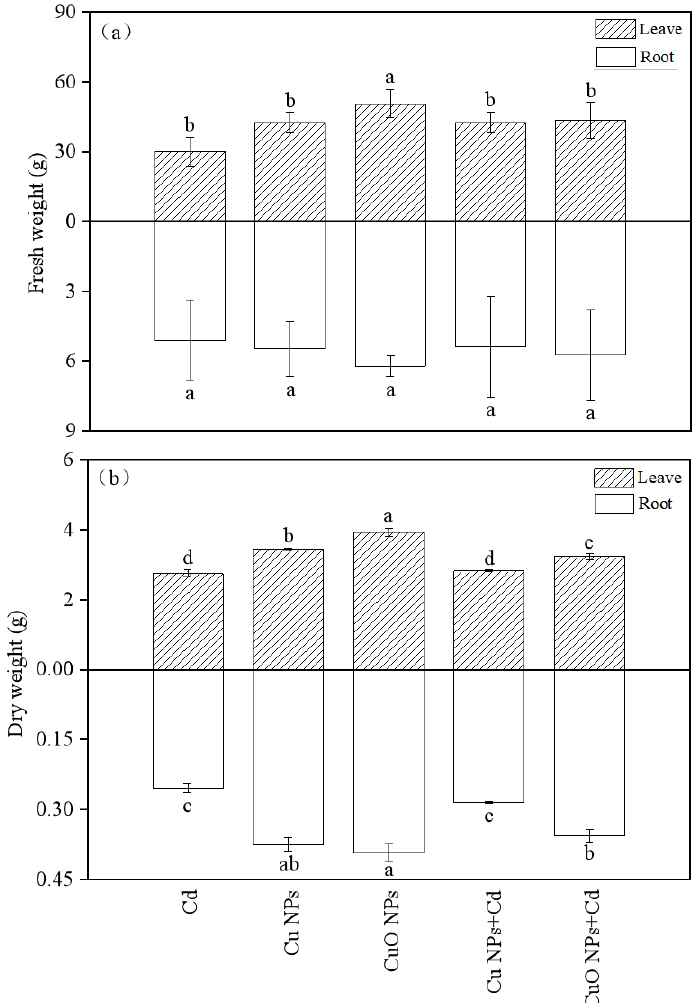
Figure 1. Effect of Cu NPs, CuO NPs and Cd on fresh weight ( a ) and dry weight ( b ) of Brassica . The means are averaged from three replicates, and the error bars correspond to the standard deviations of the three values. Different letters above each column indicate a significant difference among treatments in the same group ( p < 0.05).